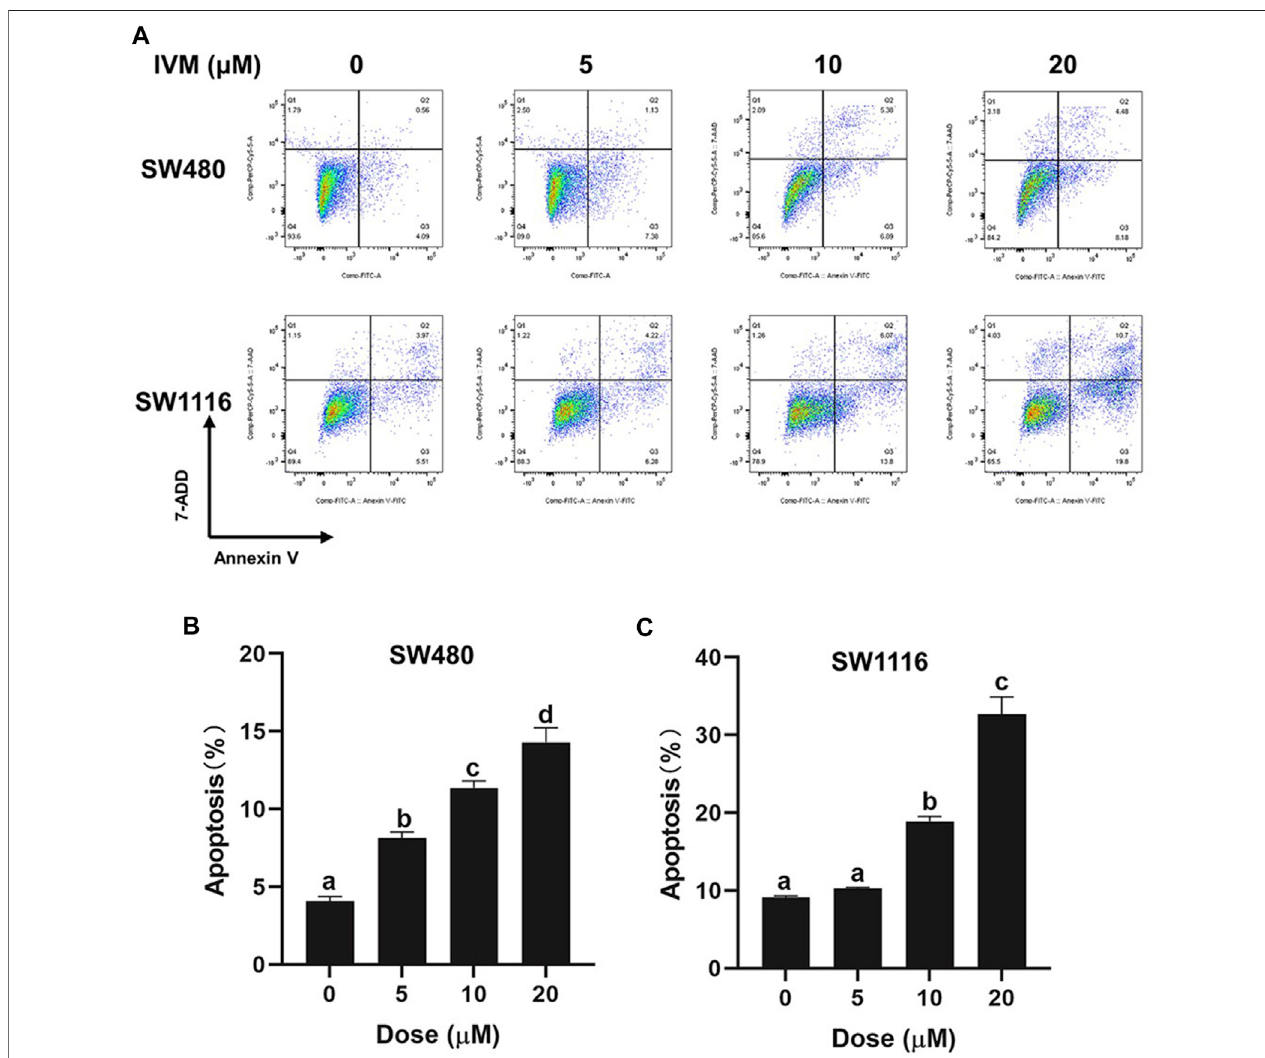
FIGURE 4 | Ivermectin induced apoptosis in colorectal cancer cells. SW480 and SW1116 cells were treated with different concentrations of ivermectin (0, 5, 10, and 20 μ M) for 6 h and then were stained, described in the “ Materials and Methods ” section. The total percentage of apoptosis is equal to the percentage of early apoptosis (Q2, Annexin V + 7-AAD - ) plus the percentage of late apoptosis (Q3, Annexin V + 7-AAD + ). Representative images from fl ow cytometry were shown in (A) . Data for SW480 (B) andSW480 (C) cellsweresummarizedand analyzed using one-wayANOVA following Tukey ’ s t -test. Thedataareshown asthemeans ± S.E.M. of three independent experiments. (a – d): same letters, no statistical difference; different letters, the statistical difference ( p < 0.05). IVM, ivermectin.